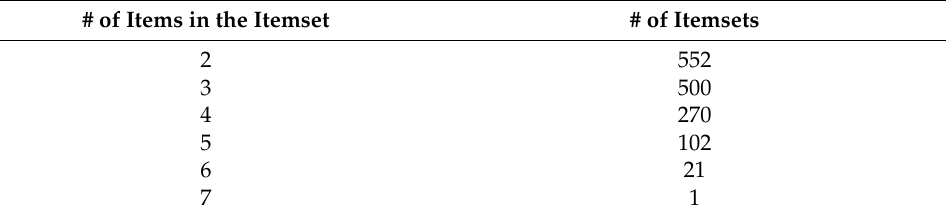
Table 7. Distribution of itemsets for Interpretation 2 applied to the large data set. # of Items in the Itemset